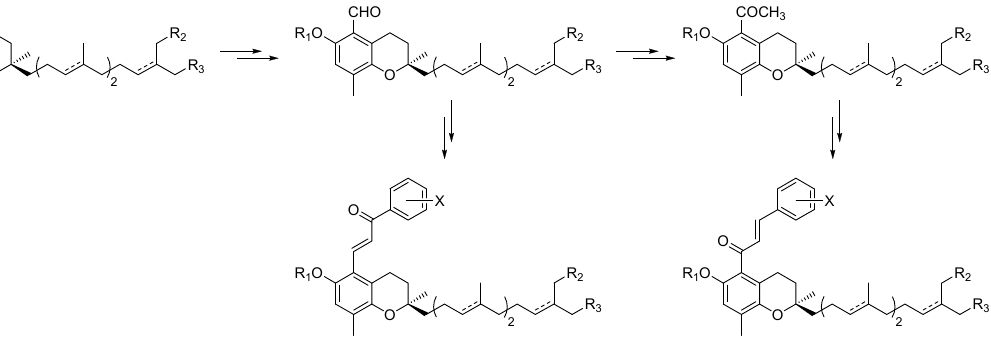
Figure 42. Semisynthetic strategies to access chalcones in the vitamin E series.